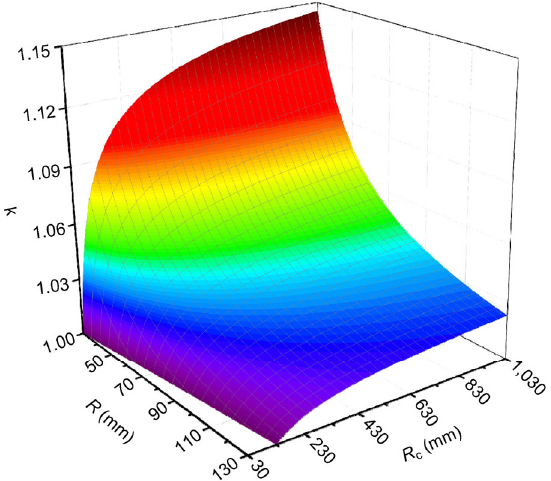
Fig. 10 Ratio between lateral magnification in the x and y directions in the corrected system ( n 1 = 1.5, n 2 = 1.0, d o =